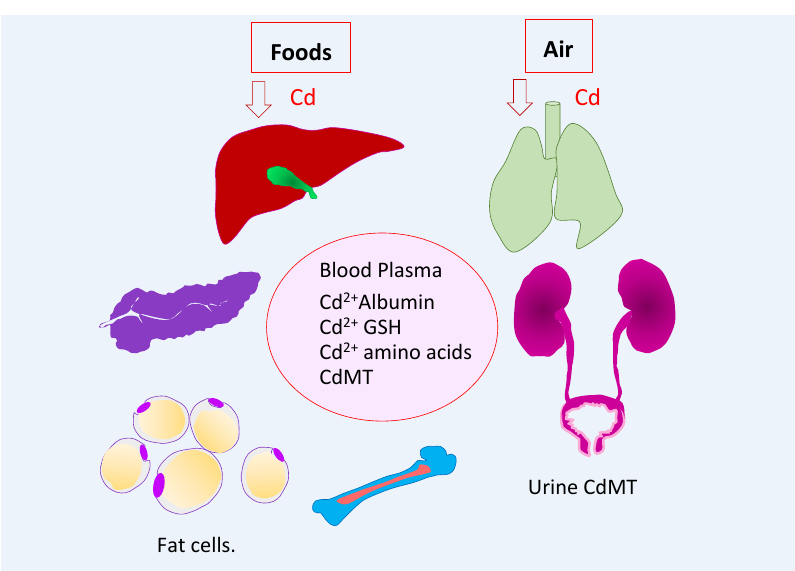
Figure 1. Entry, distribution, and exit of cadmium. Ingested Cd 2+ ions are absorbed and transported to liver, while inhaled Cd oxide and metallic Cd are transported to lungs. The fraction of absorbed Cd 2+ ions not taken up by hepatocytes in the first pass reaches systemic circulation and is assimilated by cells throughout the body. In liver and lungs, Cd induces synthesis of MT with resultant formation of CdMT with subsequent release into the circulation and reabsorption by kidney tubular cells. The Cd absorbed by the gut and lungs is eventually accumulated in the kidney tubular cells and is excreted in urine as CdMT by injured or dying tubular epithelial cells of the kidneys. The fraction of absorbed Cd not taken up by hepatocytes in the first pass reaches the systemic circulation and is taken up by tissues and organs throughout the body, including the adipose tissue [23,24], pancreas [25], lungs, liver, and kidneys [26]. All nucleated